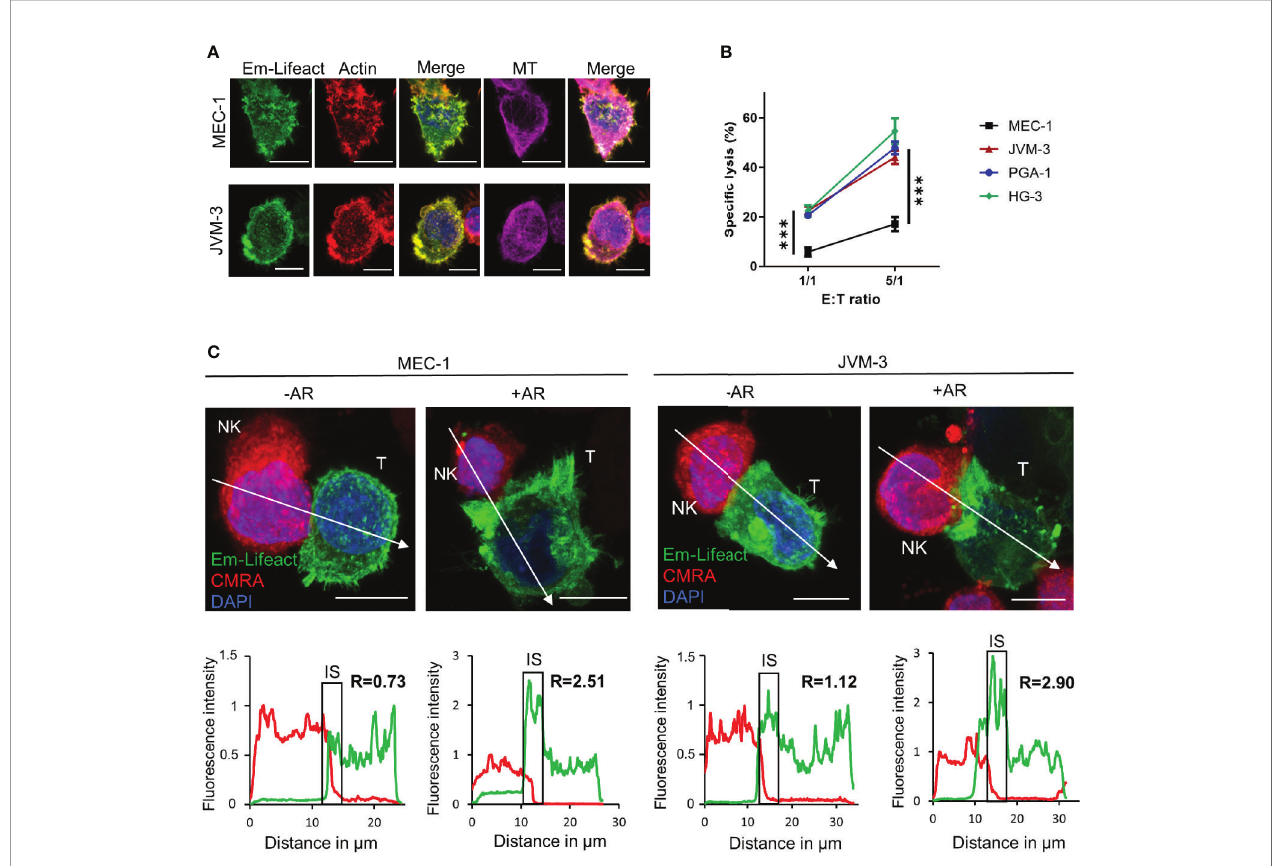
FIGURE 1 | CLL cells have the ability to respond to NK cell attack with an actin response associated to their resistance. (A) JVM-3 and MEC-1 cells were transduced to express the actin cytoskeleton marker Emerald-Lifeact (green). Stable cell lines were stained with Acti-stain 555 phalloidin (red) and anti-tubulin antibody (MT, violet). The yellow-green signal shows the co-localization of the two actin cytoskeleton probes. Bars: 10 µm. (B) Cytotoxicity assays with four CLL target cell lines and effector NK-92MI cells at 1:1 and 5:1 E:T ratios for 4 hrs. 2-way ANOVA was applied to determine statistical signi fi cance; *** denotes p < 0.0001. (C) Confocal microscopy pictures of MEC-1 (left) and JVM-3 (right) cells (T) in conjugation with NK-92MI cells (NK) with and without an actin response. The charts below show the relative fl uorescent intensity of Emerald-Lifeact and CMRA along the trajectories (white arrow). The fl uorescence was normalized to 1 at the opposite site of the synapse. The region of the immunological synapse is indicated with “ IS ” . Compared to the opposing end, target cells with an actin response have a more than 2-fold higher fl uorescent signal at the IS. Bars: